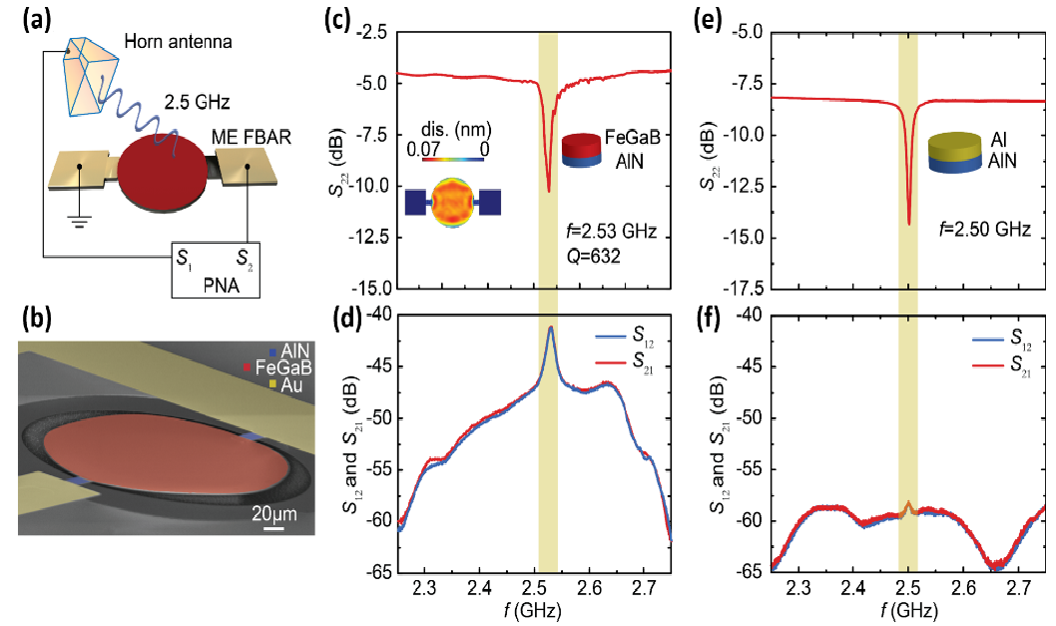
Figure 6. Thin-film based ME FBAR antennas. ( a ) Illustration of the antenna measurement setup. ( b ) SEM image of the fabricated the ME FBAR. ( c ) Return loss curve (S 22 ) of ME FBAR. The inset shows the out-of-plane displacement of the circular disk at resonance peak position. ( d ) Transmission and receiving behavior (S 12 and S 21 ) of ME FBAR. ( e ) Return loss (S 22 ) curve of the non-magnetic Al / AlN control FBAR. ( f ) Transmission and receiving behavior (S 12 and S 21 ) of the non-magnetic Al / AlN control FBAR. Reprinted with permission from [43]. Copyright [2017], Springer Nature.